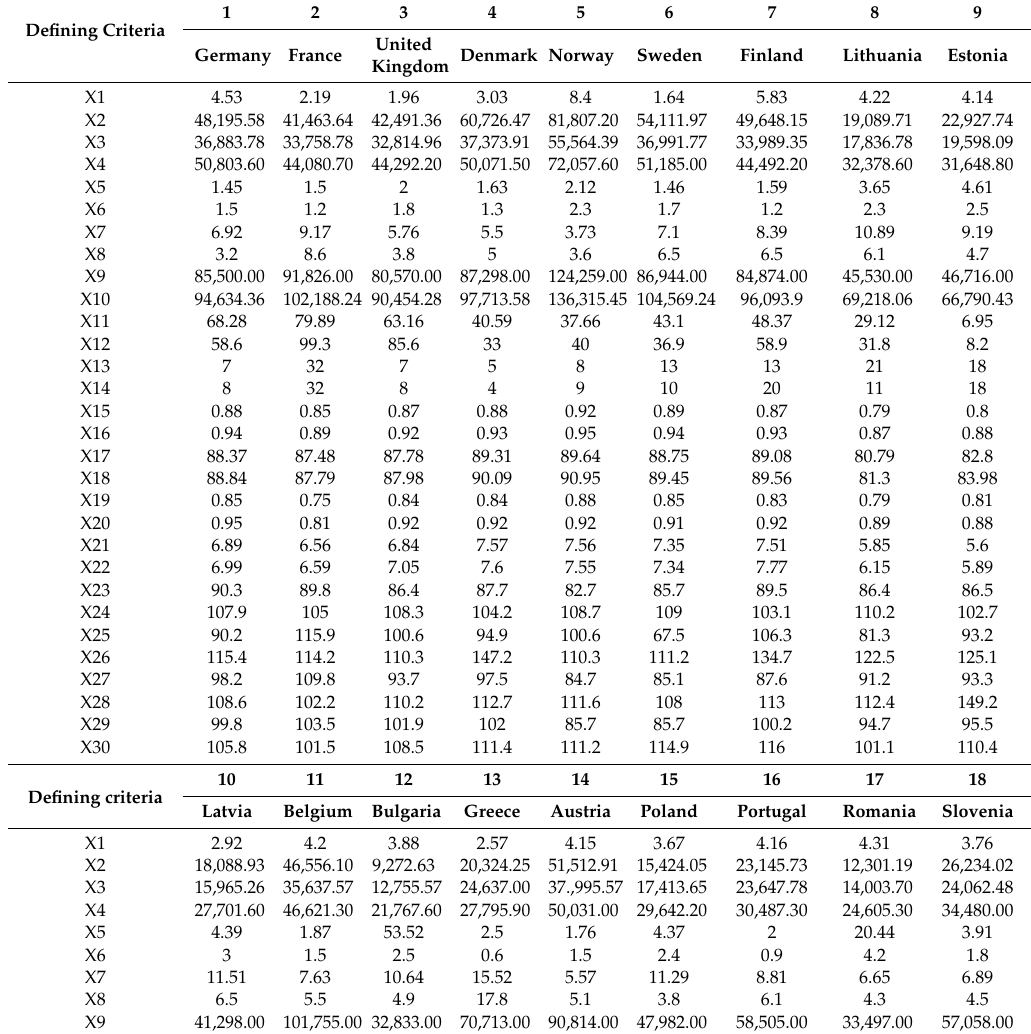
Table A1. The sustainable construction industry multiple criteria evaluation for 25 EU member states, the UK and